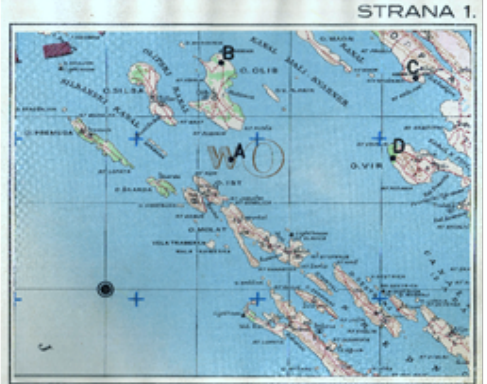
Figure 2. Example layout of topographic map with focal point used for T5 test.